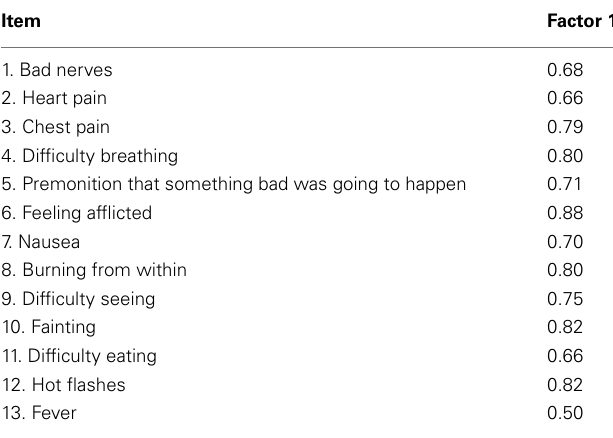
Table 1 | Factor loadings of the items of theAgonias